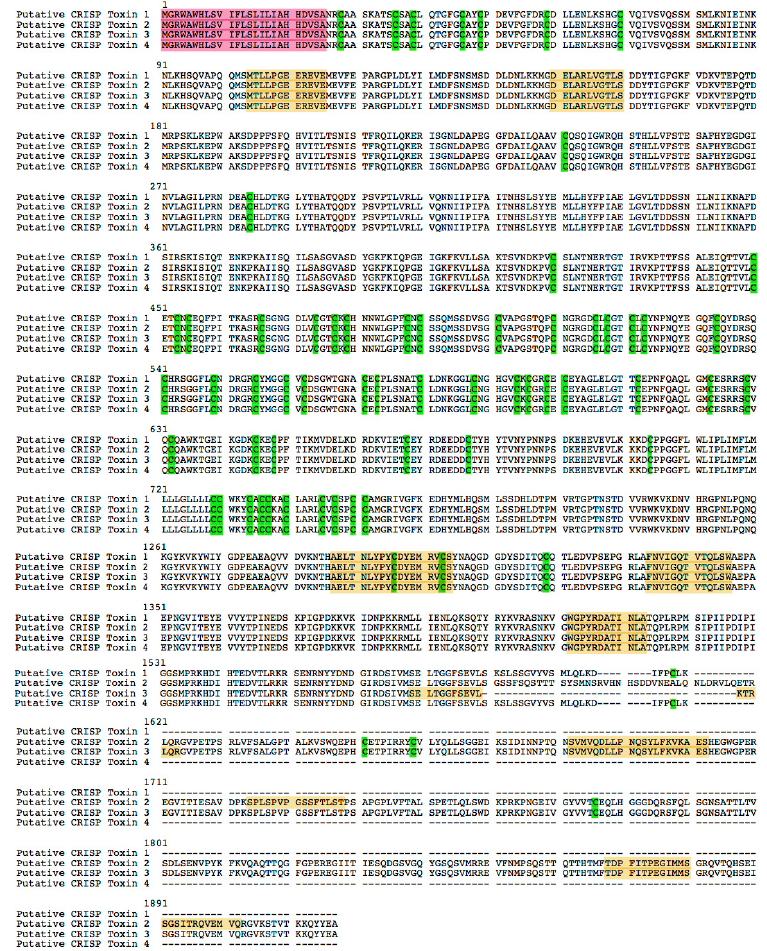
Figure 9. The putative CRISP toxin sequences from Chinese yellow catfish. Sequences in red background are signal peptides. Peptides in yellow background are verified by LC-MS/MS analysis. The amino acid Cysteine is marked in green. Dashed lines means the absence of corresponding amino acid sequences.